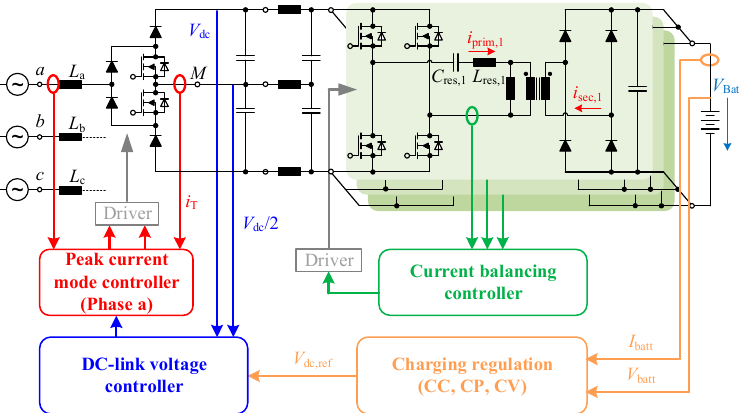
Figure 21. Two-stage system control: Peak current mode controller for PFC function (red control loop), dc-link voltage regulation and balancing (blue control loop), charging regulation (orange control loop), and power balancing of the individual LLC converter phases (green control loop).